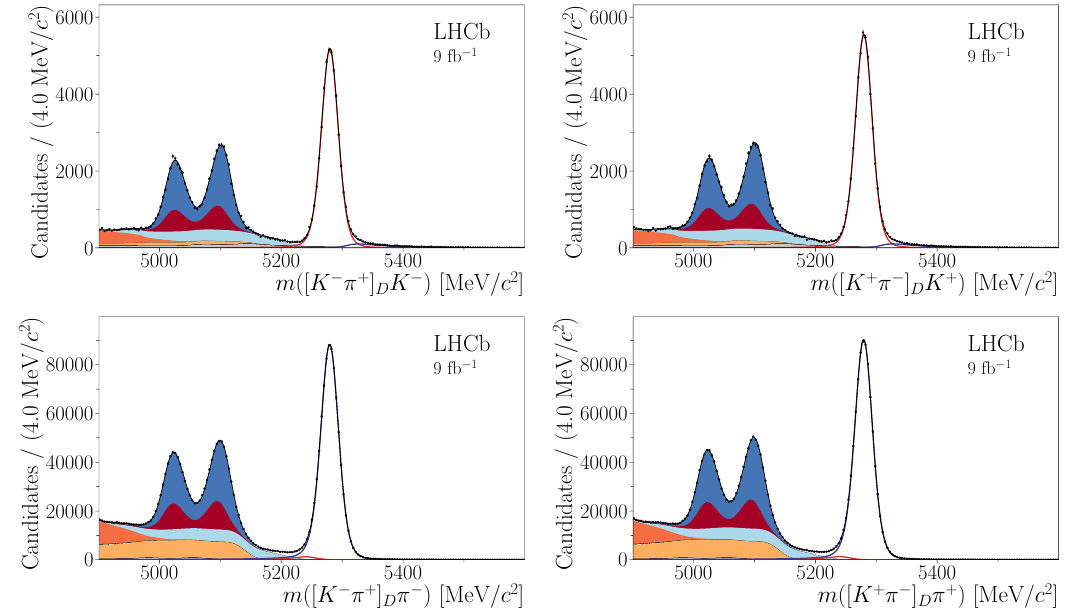
Figure 2 . Invariant-mass distribution of selected B ± → [ K ± π ∓ ] D h ± candidates. The result of the fit is shown by the solid navy line, and each component is listed in a legend provided in figure 1.